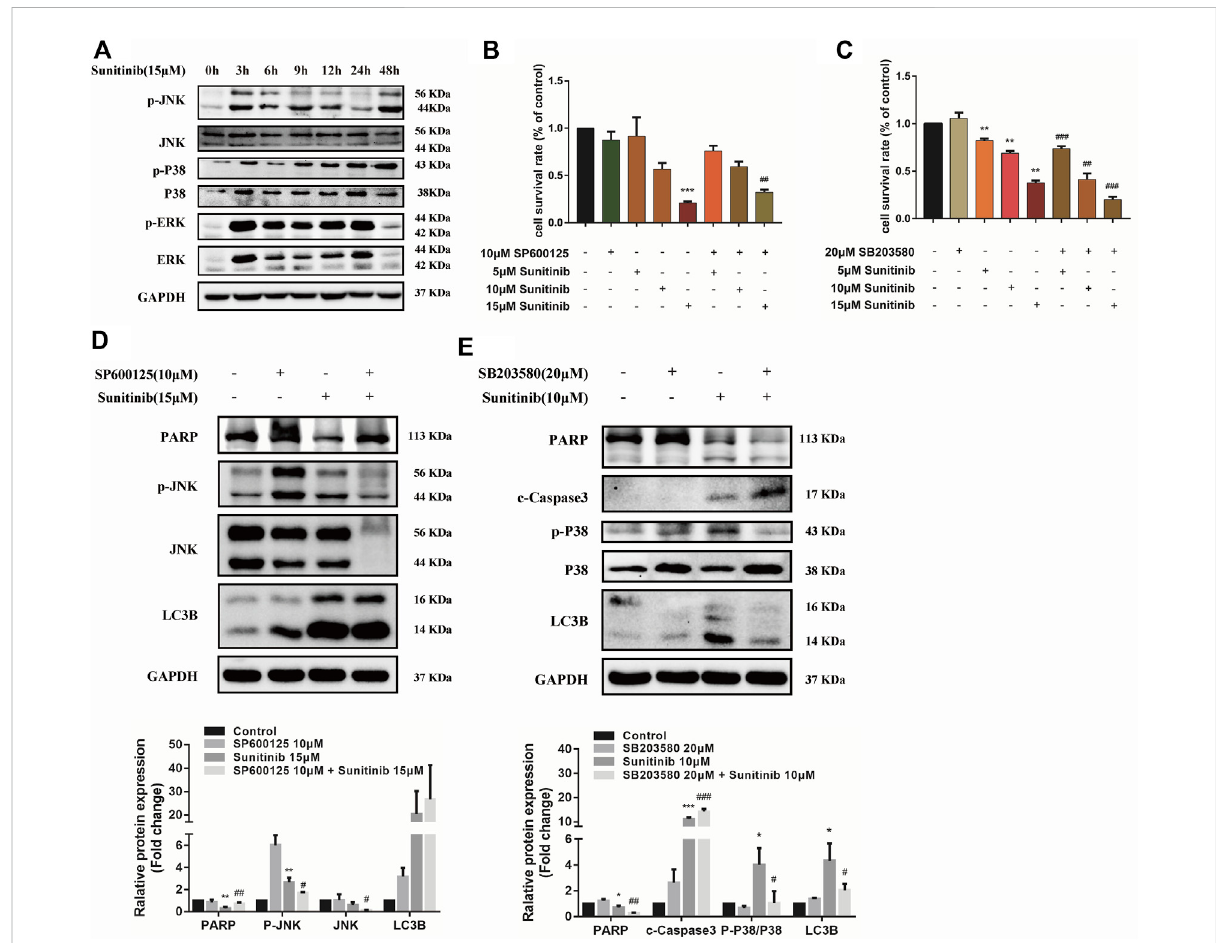
FIGURE 4 Sunitinib regulates apoptosis and autophagy via MAPKs pathway. (A) Detection proteins expression of JNK, P38, ERK and their phosphorylation incubated with Sunitinib (15 μ M) for 0 – 48 h. (B) The viability of hepatocytes was analyzed by MTT after L02 cells were incubated with 5, 10, 15 μ M Sunitinib for 24 h in the presence or absence of 10 μ M SP600125 pretreatment for 2 h ( n = 6). (C) The viability of hepatocytes was analyzed by MTT after L02 cells were incubated with 5, 10, 15 μ M Sunitinib for 48 h in the presence or absence of 20 μ M SB203580 pretreatment for 2 h ( n = 6). (D) Protein expression of p-JNK, JNK, PARP, and LC3B after L02 cells were incubated with 15 μ M Sunitinib for 24 h in the presence or absence of 10 μ MSP600125pretreatmentfor 2 h( n = 3). (E) Protein expression ofp-P38, P38, PARP, c-Caspase3, and LC3B after L02cells were incubated